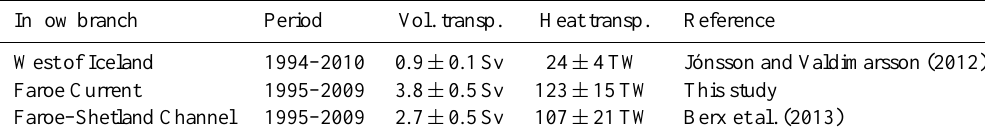
Table 4. Average volume and heat (relative to 0 ◦ C) transport in the three Atlantic inflow branches based on long-term in situ